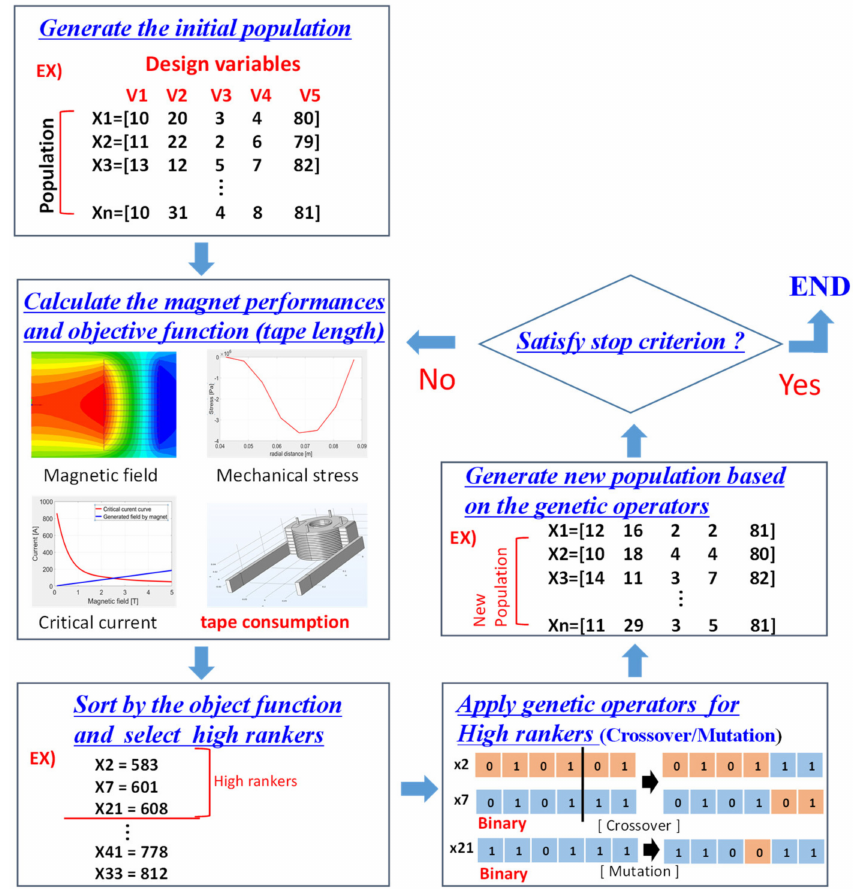
Figure 4. Magnet design algorithm based on the GA. The center field and field homogeneity constraints are related to the axial-direction magnetic field in the air core space. The axial-direction magnetic field with a